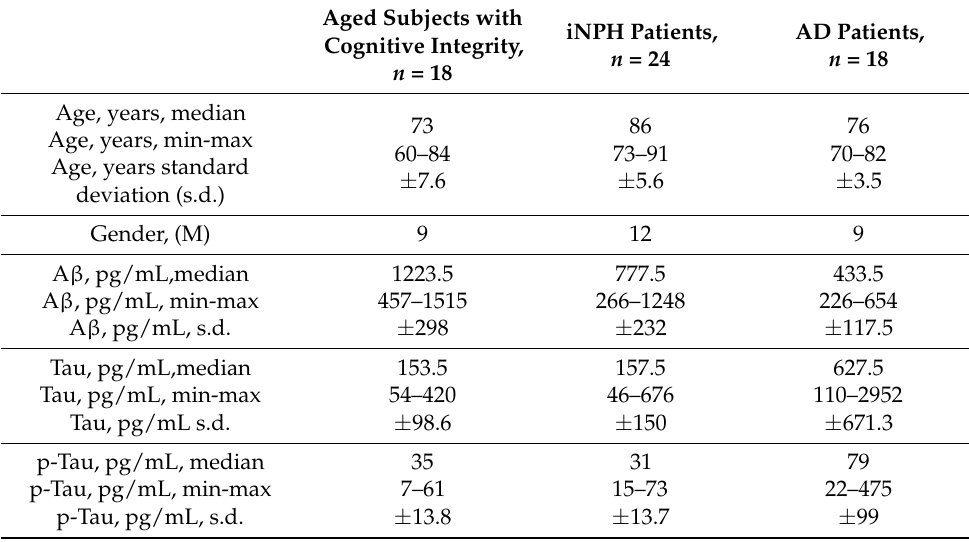
Table 1. Participants’ characteristics.